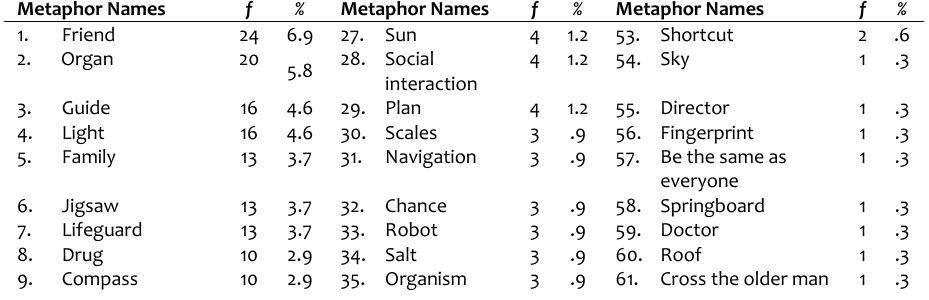
Table 1. Metaphors produced by special education pre-service teachers regarding